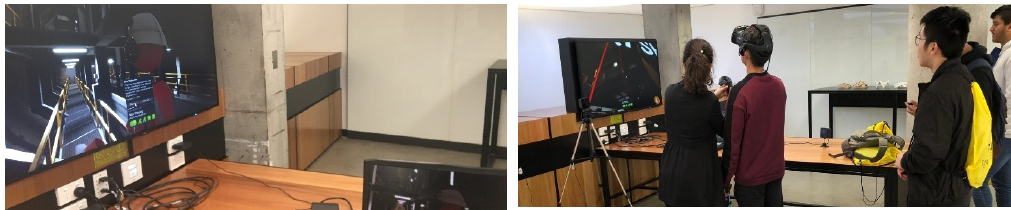
Figure 11. Utilising the VTBM on a large screen in an open studying space at FBE (left) and experiencing the VTBM using both a monitor and an HTC Vive Pro headset with another user logging into the VTBM from a different place in a collaborative multiplayer manner (right).